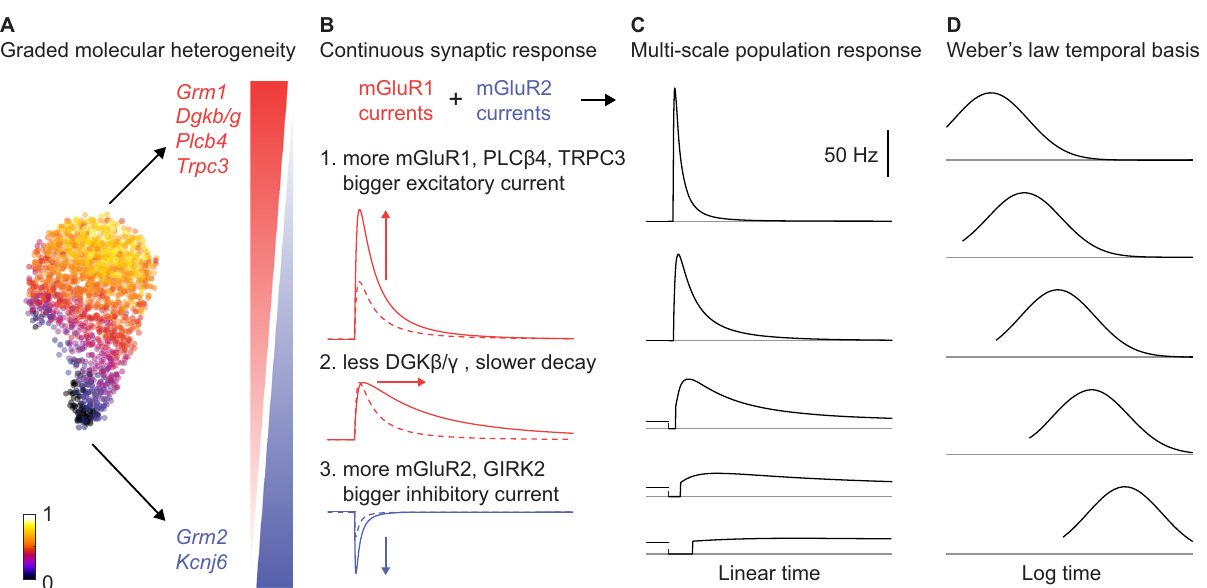
Fig. 7 Schematic showing the roles of mGluR2/3, mGluR1 and DGK in controlling responses evoked by MF activation. A UMAP with latent factor loading (left) and major genes involved in synaptic transmission that are differentially regulated along the gradient of the latent factor (right). B Schematics summarizing the role of the mGluR1 pathway, including DGK β / γ (red) and the mGluR2/3 pathway (blue) in continuous changes in synaptic responses. C Schematics of temporal responses from a small group of UBCs showing the multiscale nature of temporal representation at a population level. D Same fi ve cells normalized and replotted on a logarithmic time axis clearly demonstrate the Weber ’ s law behavior of the UBC population temporal basis and its ability to support learning over multiple